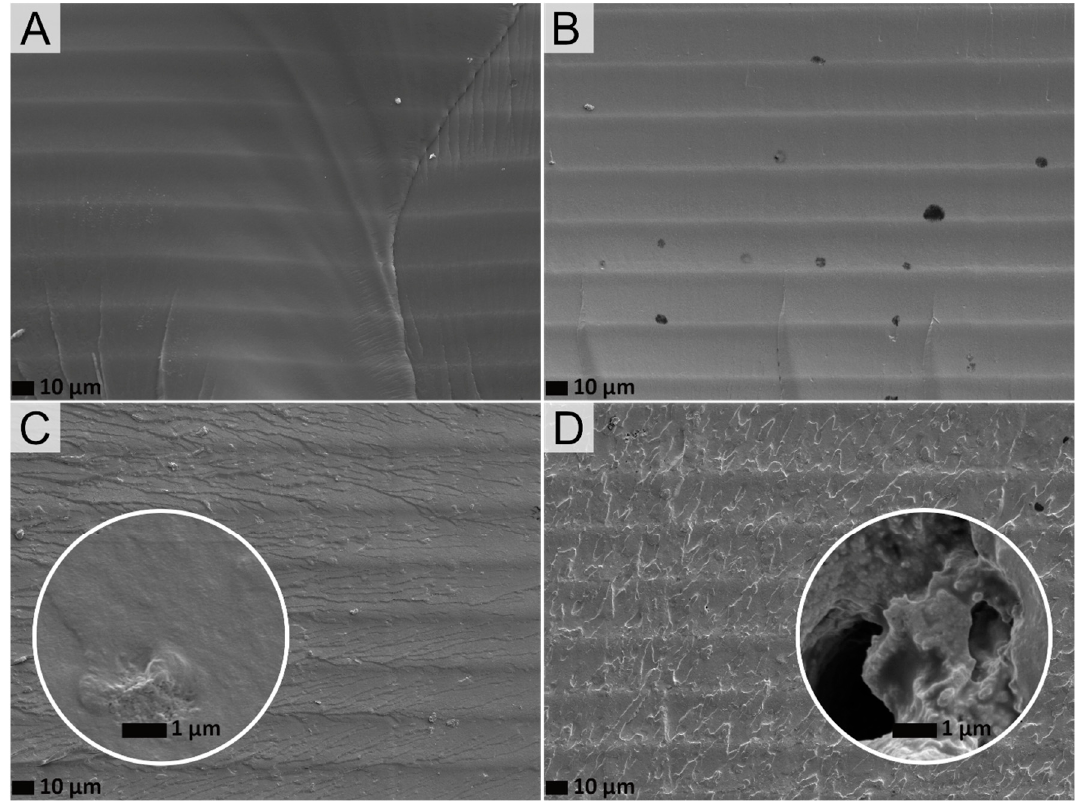
Figure 4. Representative SEM images of cryo-fractured cross-sections of ( A ) LG0, ( B ) LG1, ( C ) LG2, and ( D ) LG35 with magnitude amplification of 500× and 10,000× for the inset. The KBr FT-IR spectrum of lignin is plotted in Figure 2B in comparison with the ATR spectra of the liquid monomers mixture, the pristine acrylic matrix, and the composite LG35. The spectrum of lignin showed typical lignin patterns after organosolv fractiona- tion. The stretching vibrations of hydroxyl, CH alkane, carbonyl, and typical aromatic skeletal vibrations were observed at 3425 ( ν OH ), 2936, and 2851 ( ν C-H ), 1734 ( ν C=O ), 1616, 1508, and 1425 ( ν C-=C ) cm − 1 , respectively. An absorption at 1463 cm − 1 related to C-H bending